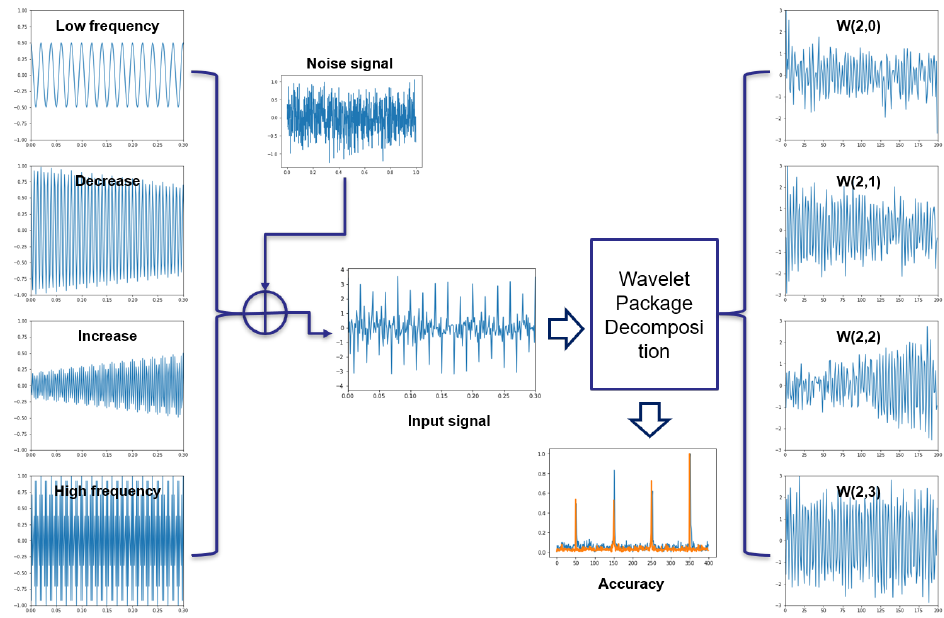
Figure 5. Resolution result of different mixed signals by using Level 2